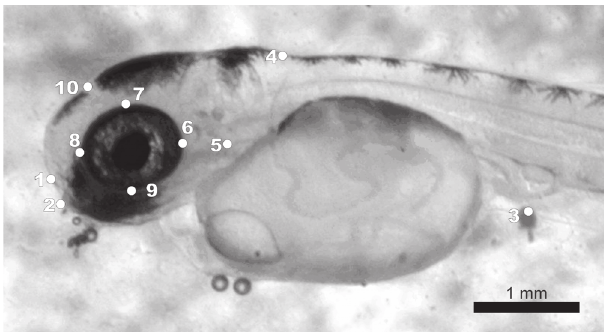
Fig. 1. Homologous landmarks on the left lateral view of a newly hatched free embryo: (1) anterior tip of premaxilla, (2) anterior tip of dentary, (3) anus, (4) dorsal profile of the body at the posterior end of operculum, (5) angle of the first gill arch, between epihyal and ceratobranchial, (6, 7, 8, and 9) dorsal, ventral, anterior and posterior edge of eye, and (10) limit between diencephalon and telencephalon.